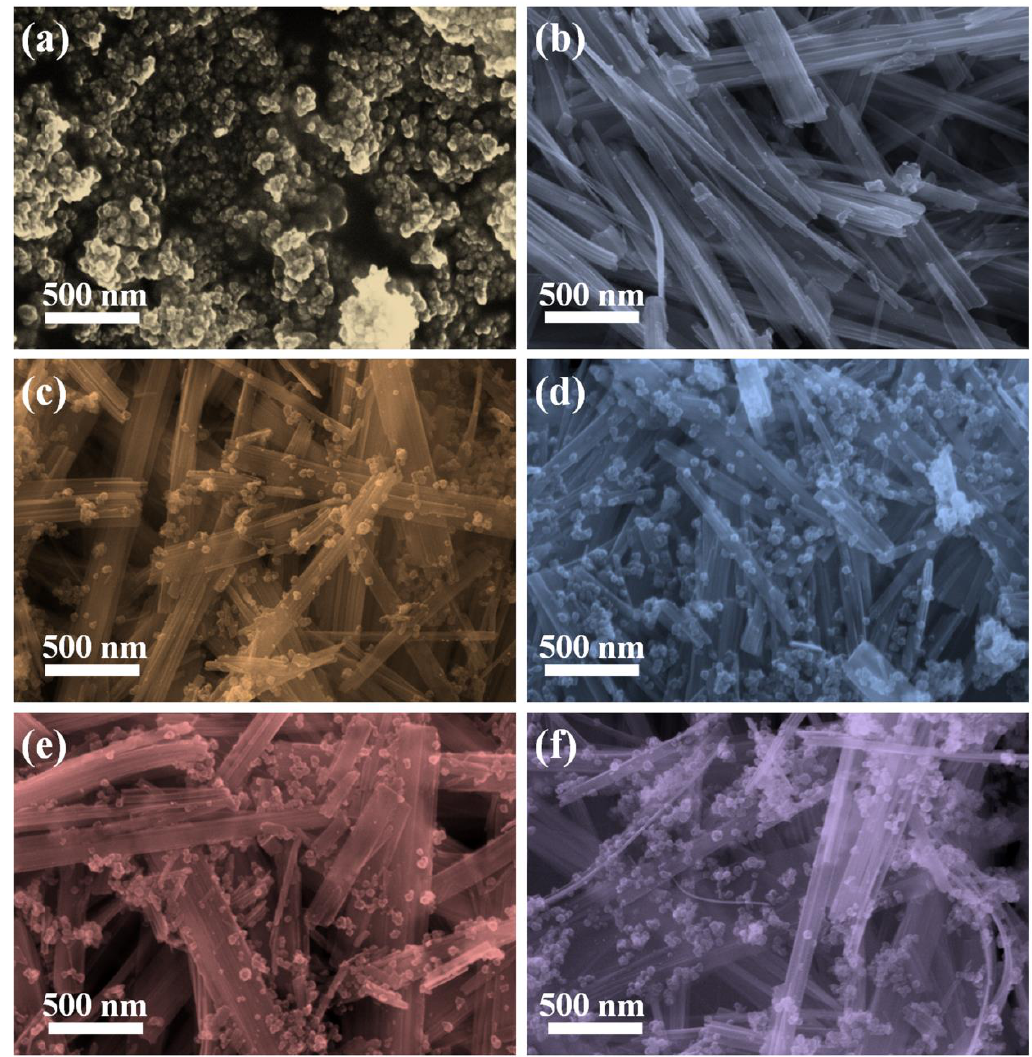
Figure 2. ( a – f ) SEM images of TiO 2 , Ag 2 V 4 O 11 and TiO 2 /Ag 2 V 4 O 11 nannoheterojunctions with set molar ratio of 1:1, 2:1,4:1 and 8:1 samples (recorded as T, A, TA1, TA2, TA4, and TA8), respectively.